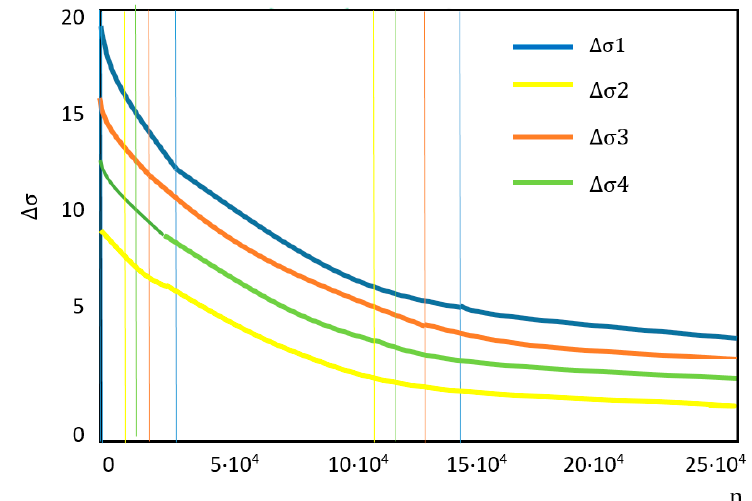
Figure 4. Durability curves of fittings in linear coordinates.